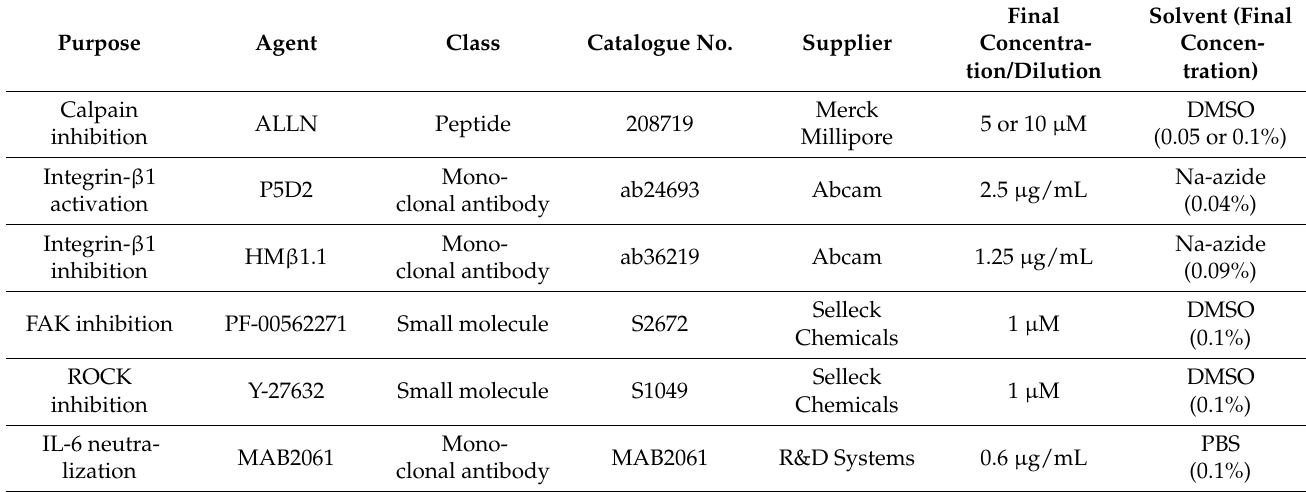
Table 1. Targets, compounds, and concentrations used in this